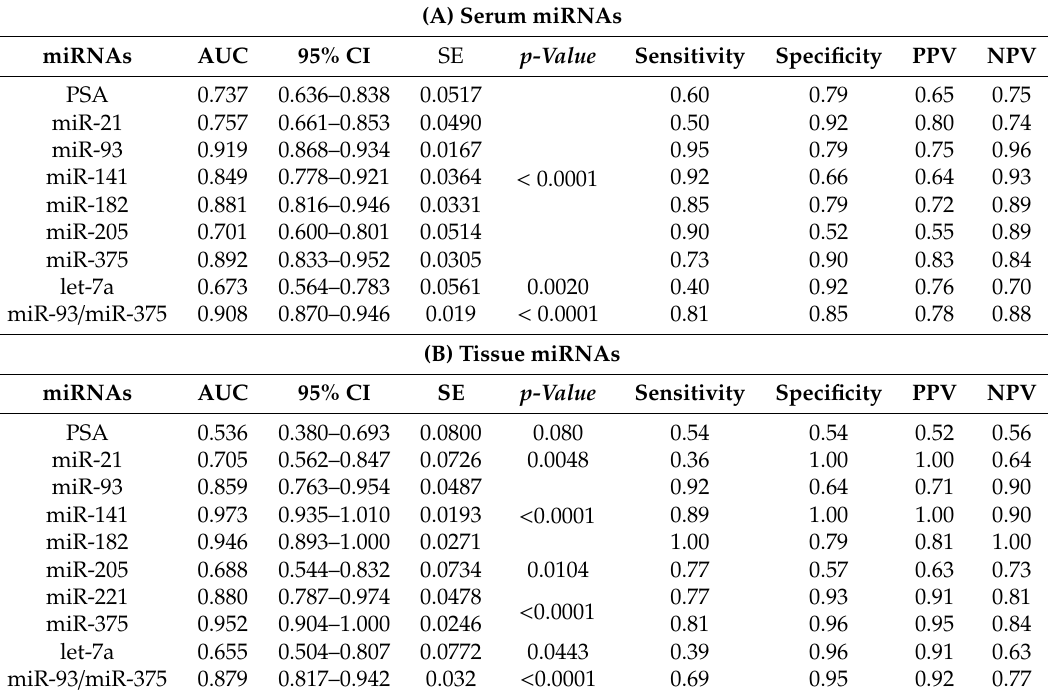
Table 3. Discriminatory potential of statistically significant miRNAs and PSA in serum ( A , n = 102) and tissue ( B , n = 54) samples.